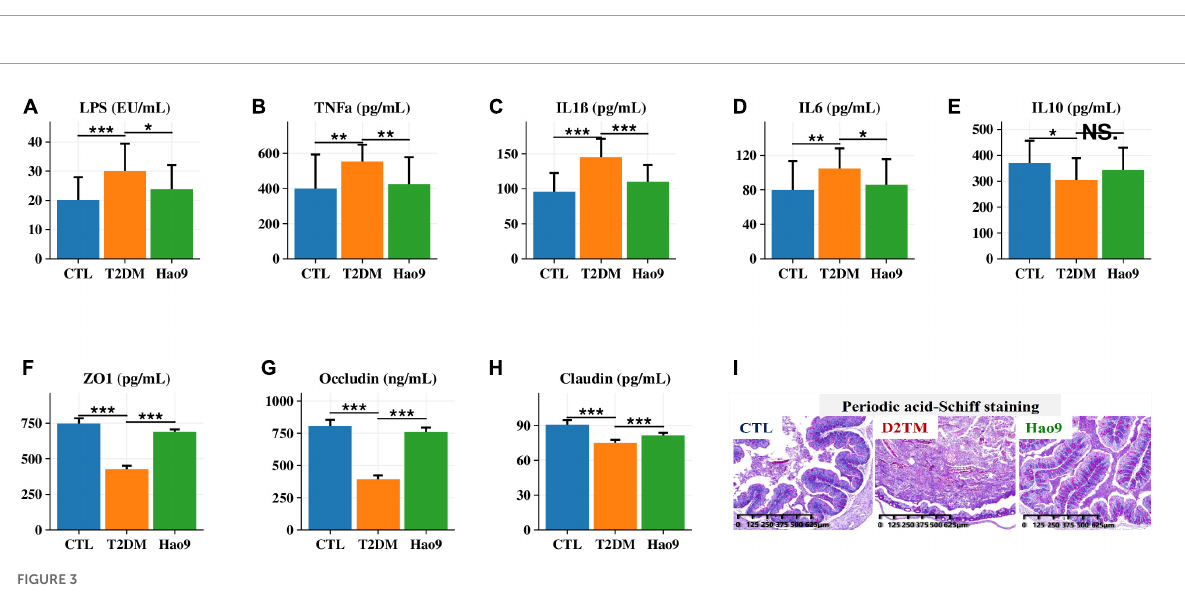
FIGURE2 Protective effect of Hao9 on liver and hepatic glucose metabolism in T2DM mice. (A) Dihydroethidium (DHE) staining showed that Hao9 ameliorated hepatic reactive oxygen species, and Masson staining showed that Hao9 ameliorated the increase of collagen fibers in liver tissue caused by T2DM. Effect of Hao9 on hepatic catalase (CAT) (B) and superoxide dismutase (SOD) (C) levels. Effect of Hao9 on glucose-6-phosphatase (G6Pase) (D) and phosphoenolpyruvate carboxykinase (PEPCK) (E) mRNA expression in liver. In bar plots (B–E) we used mean ± standard deviation (SD) to describe differences between groups and *** p < 0.001.